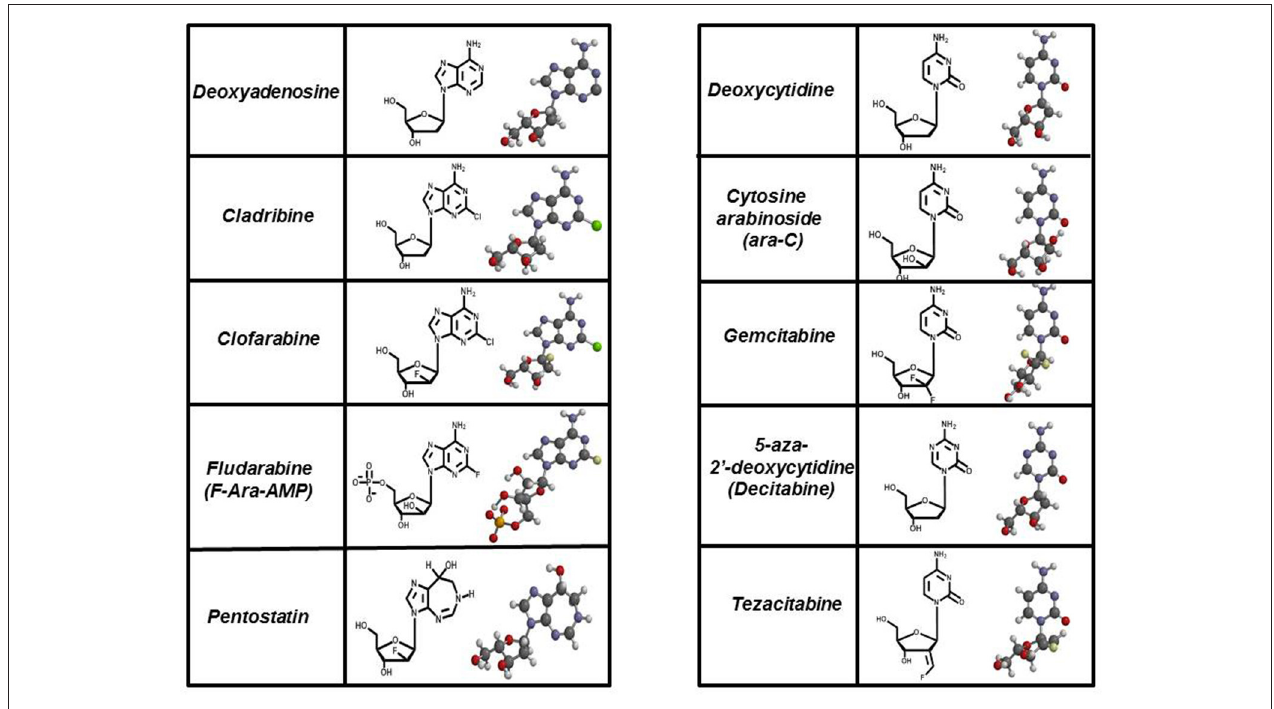
FIGURE 5 | Structures of FDA approved nucleoside analogs. Purine-like nucleosides include cladribine (2-chlorodeoxyadenosine), clofarabine [2-chloro-9-(2 ′ deoxy-2 ′ -fluoroarabinofuranosyl)adenine], fludarabine (9- β -D-arabinoside-2-fluoroadenine), and pentostatin (2 ′ -deoxycoformycin). Pyrimidine-like nucleosides include cytarabine [1- β -D-arabinofuranosylcytosine (Ara-C)], gemcitabine [2 ′ ,2 ′ -difluorodeoxycytidine (dFdC)], 5-aza-deoxycytidine, and tezacitabine.